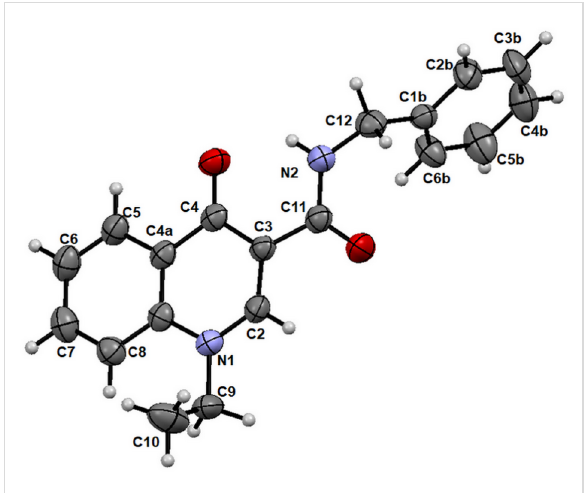
Figure 6: Asymmetric unit of product 7